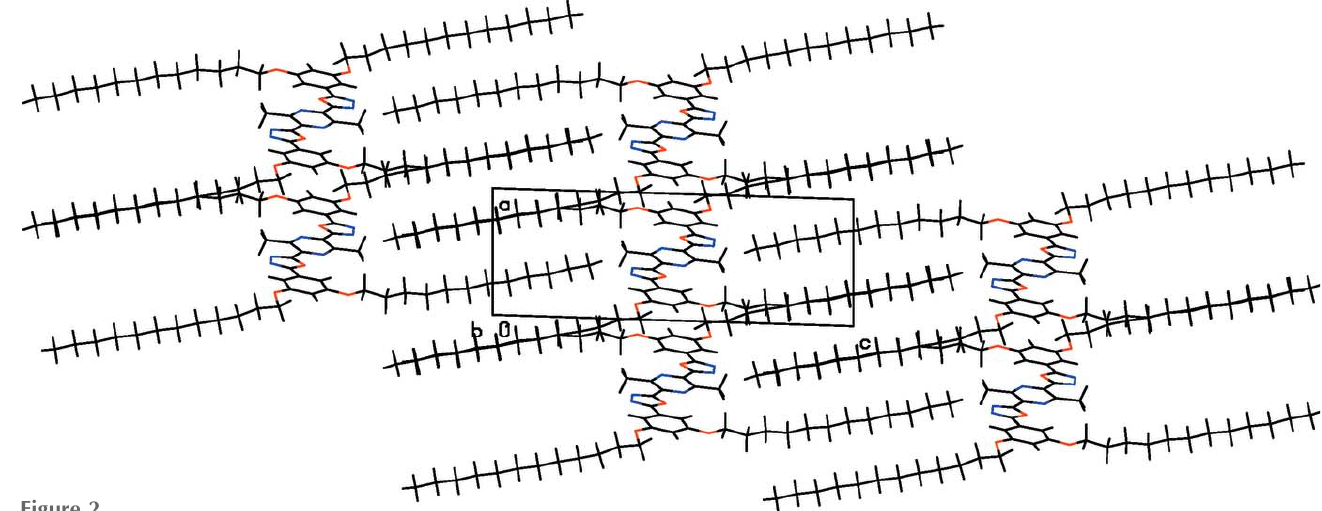
Figure 2 Partial packing diagram. View along the b